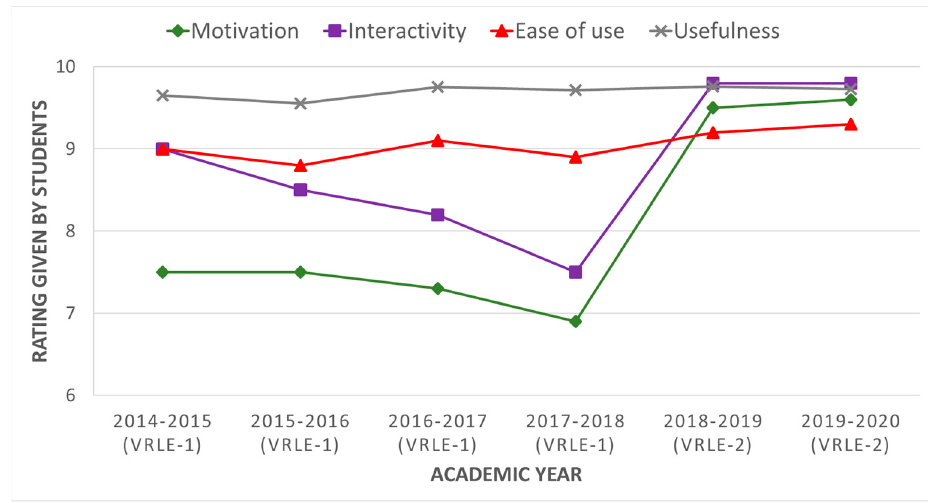
Figure 7. KPIs values of the VRLE of CL over another period of academic years (former version, VRLE-1, and later version, VRLE-2).